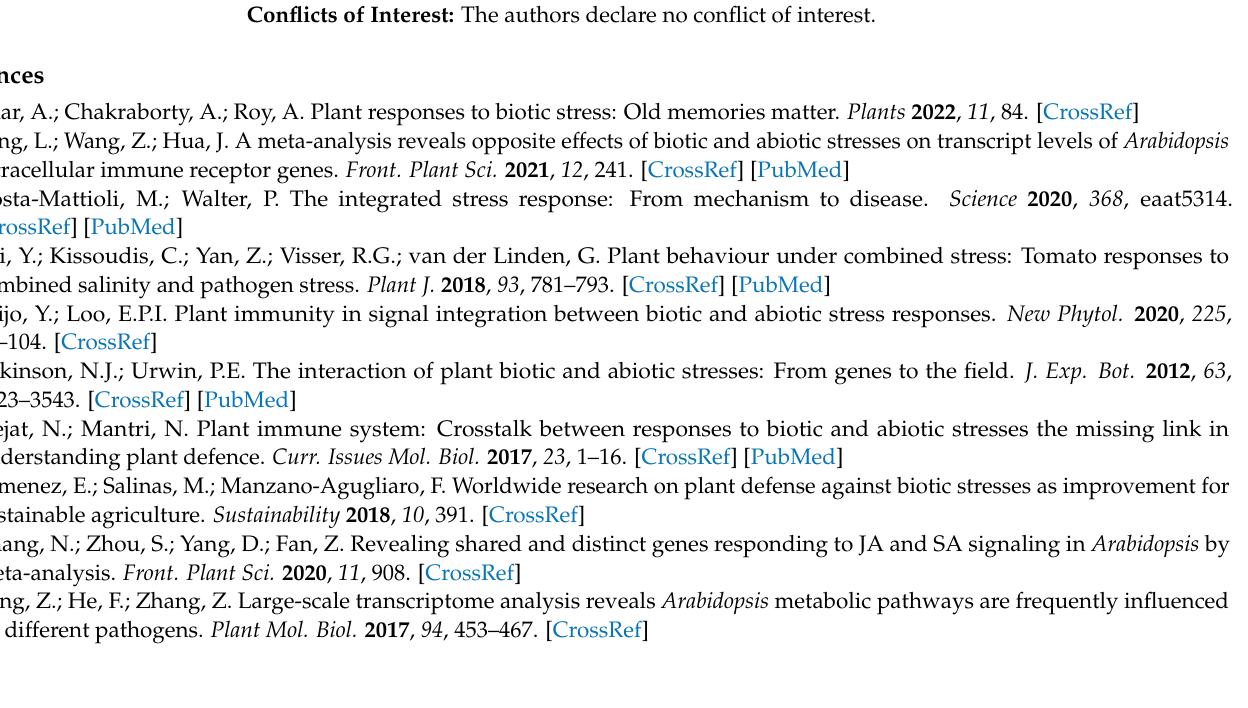
Table S3: Identified transcription factors in response to biotic and abiotic stresses, Table S4: miRNAs associated with the DEGs were discovered using the computational algorithm psRNATarget